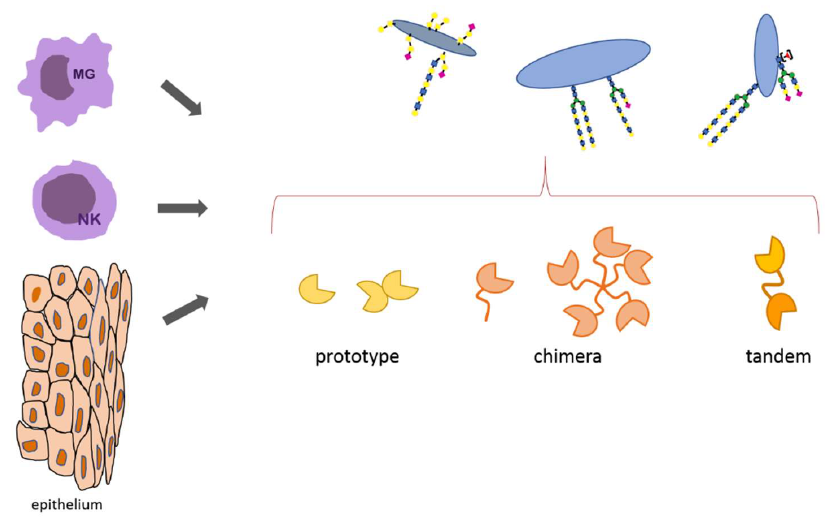
Figure 5. Examples of galectin secreting cells/tissues, their structures, and glycan